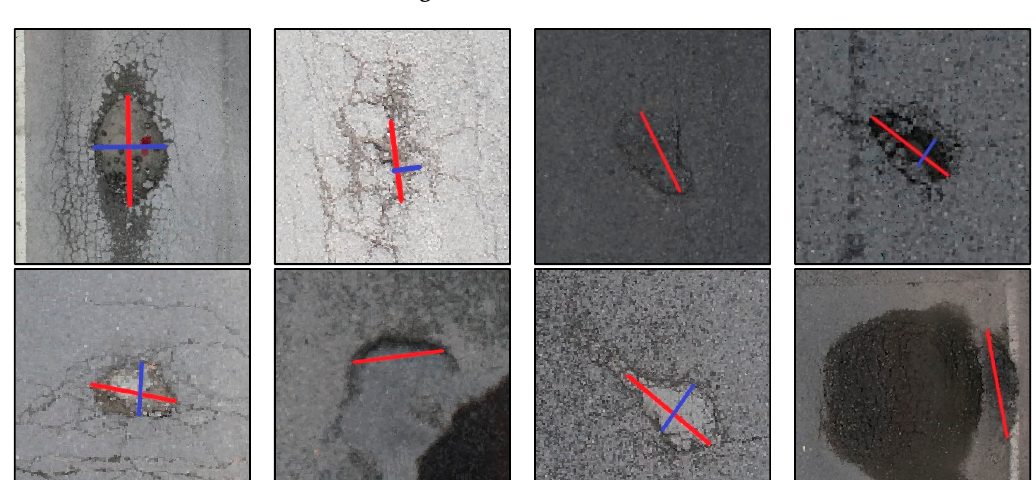
Figure 19. Road models.